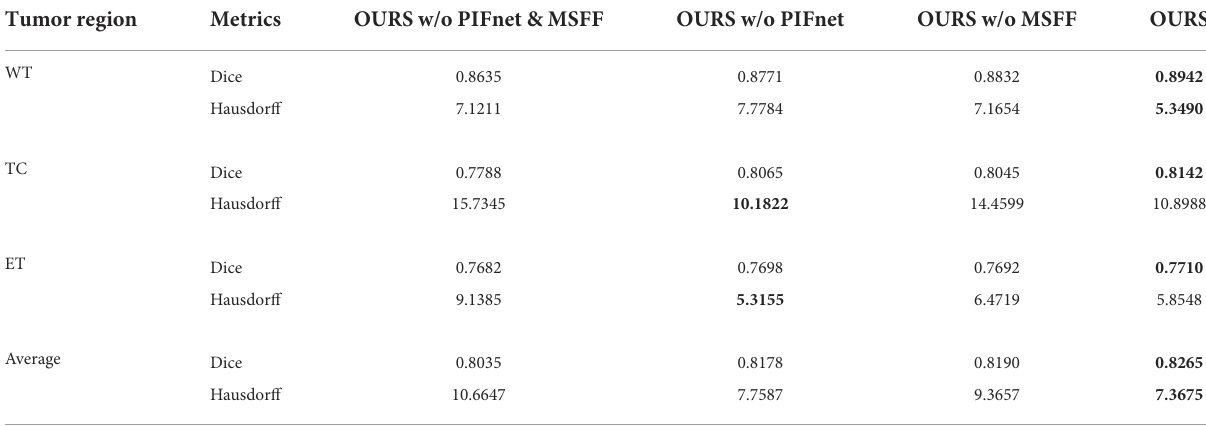
TABLE 2 Objective evaluation results for the ablation study of the proposed method on the BraTS 2019 validation sets. Tumor region